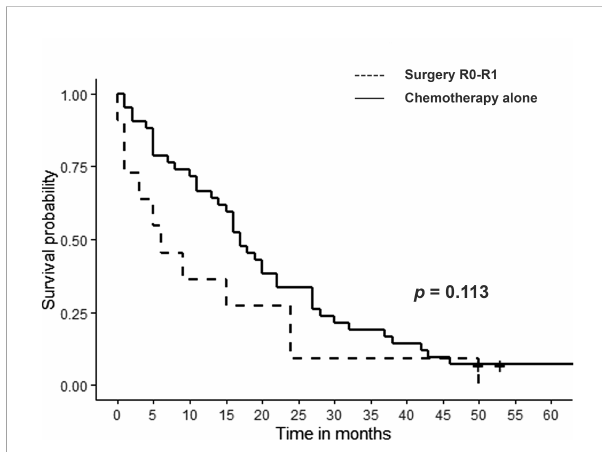
FIGURE 3 Survival after cholangiocarcinoma recurrence: R0/R1 resection vs systemic chemotherapy only